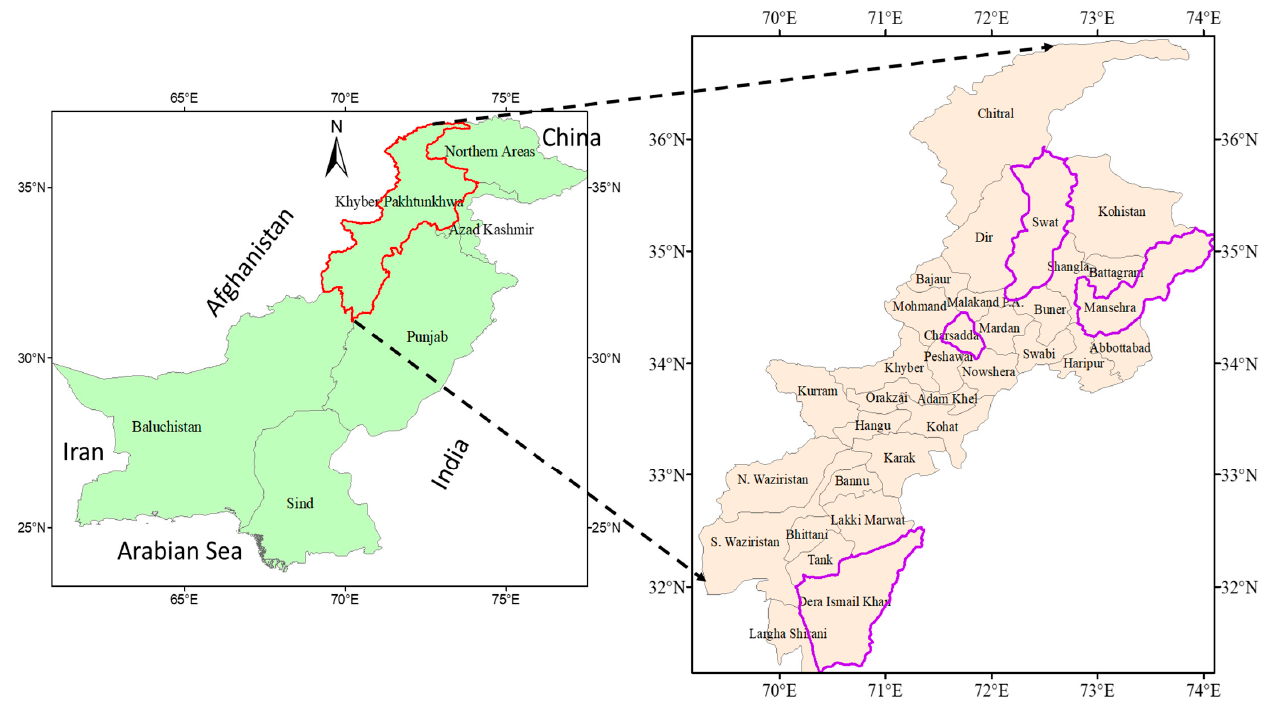
Figure 3. Map of the study area. The selected four district’s boundaries are shown in pink color [37]. In the second stage, one tehsil was selected to fill out questionnaires, and in the third stage, one union council was targeted from each tehsil. In the fourth stage, four villages